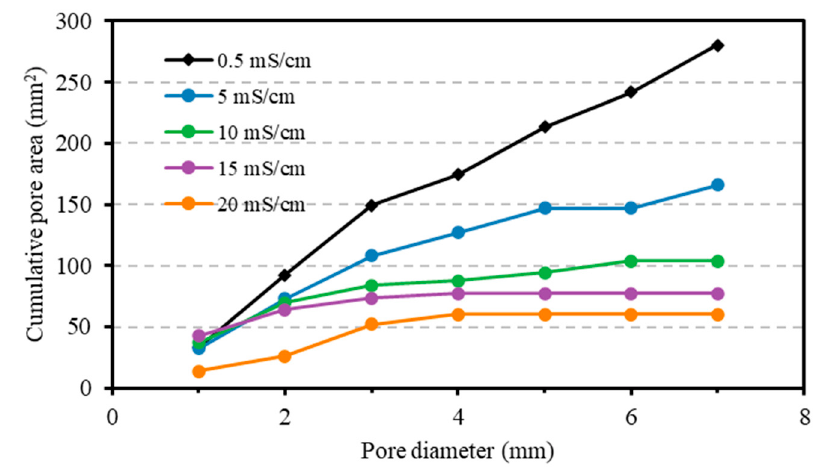
Figure 13. Cumulative pore area of samples broken by pressure waves.